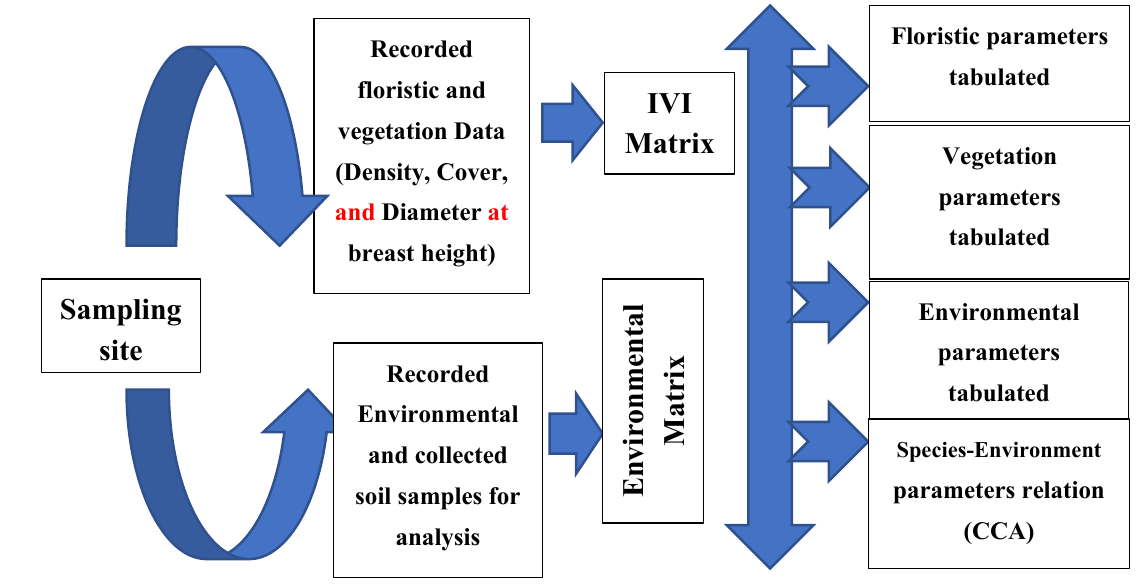
Figure 2. Flow chart of the methodology.